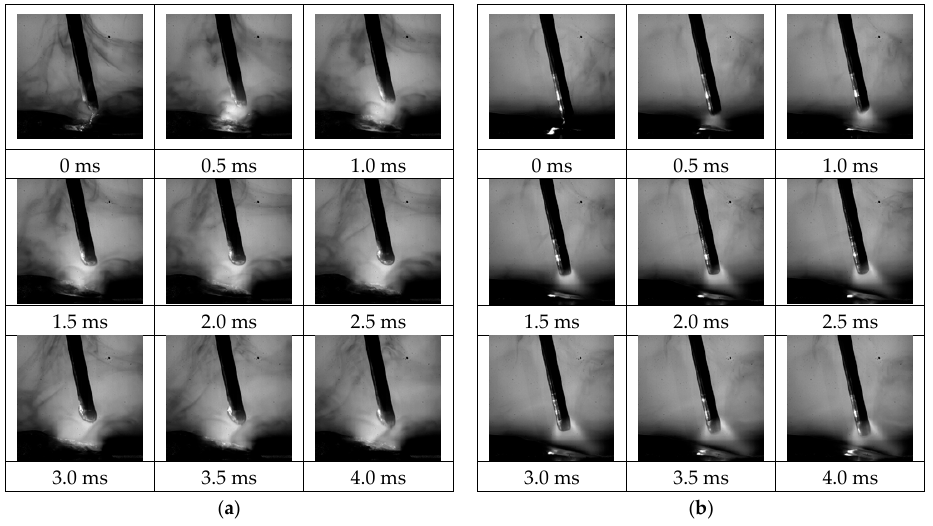
Figure 9. High ‐ speed images during the cold ‐ metal ‐ transfer mode welding: ( a ) AZ31 ‐ A; ( b ) AZ31 ‐ B.